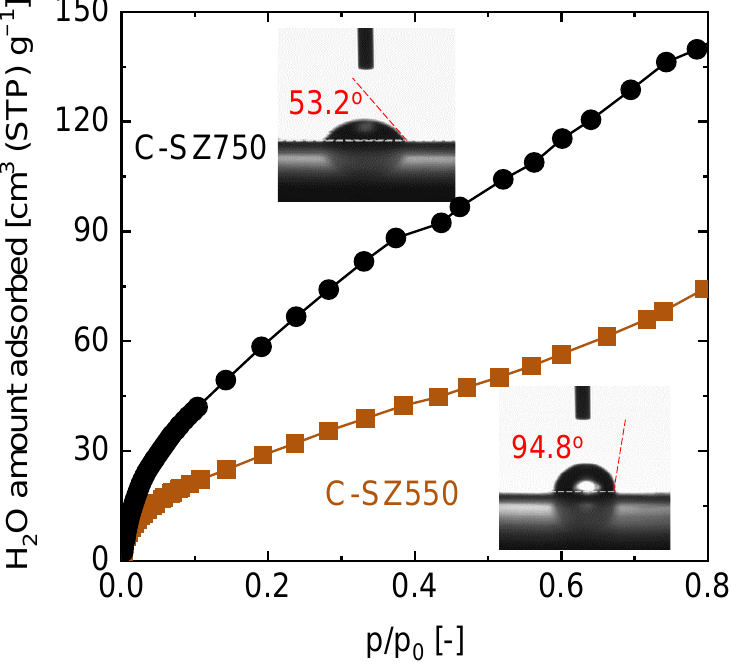
Figure 6. H 2 O adsorption isotherms measured at 25 °C of carbon-SiO 2 -ZrO 2 (C-SZ) powders derived after the pyrolysis of 200 °C-cured SiO 2 -ZrO 2 -polybenzoxzine resins at 550 and 750 °C (Inset: Water- contact angles of respective carbon-SiO 2 -ZrO 2 films).